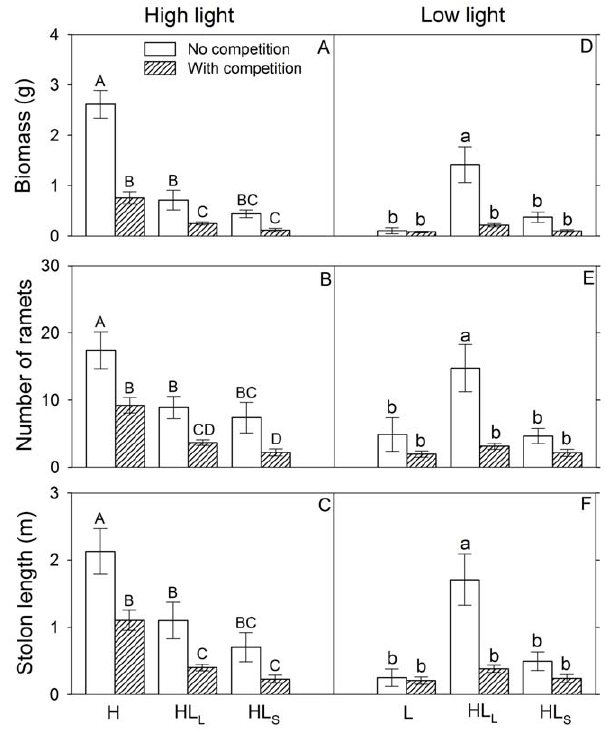
Figure 4. Effects of competition and light heterogeneity on growth measures of Duchesneaindica . Bars in the left panels (A–C) are mean values ( + SE) of three growth measures in the high light patches and bars in the right panels (D–F) are those in the low light patches. Bars sharing the same letters are not different at P =0.05. Bars are mean values ( + SE). Treatment codes are in Figure 1.